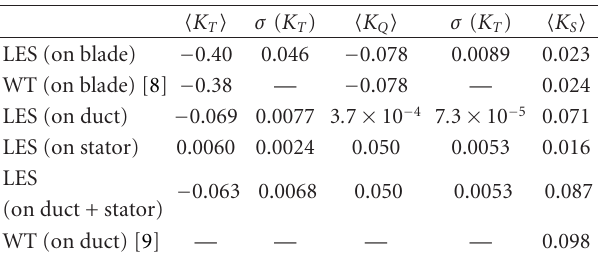
Figure 17: Instantaneous flow fields over ducted propulsor with stator blades at J = − 0 . 7: (a) pressure in x − z plane, (b) pressure on propulsor surface. Table 6: Statistics of unsteady loads for ducted propulsor with stator blades at J = − 0 .